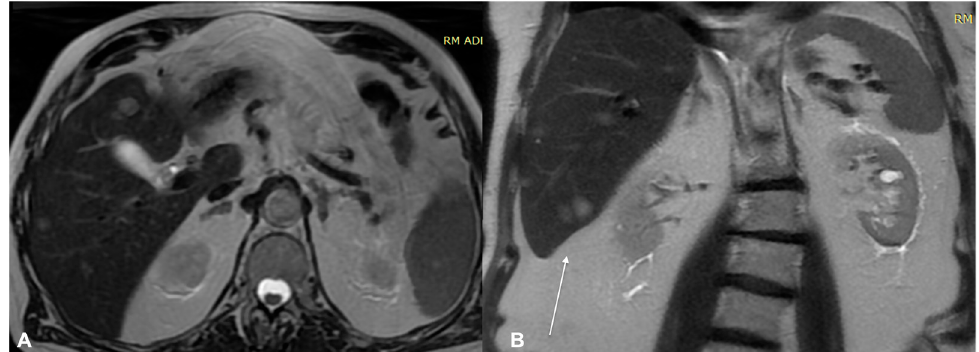
Figure 10. MRI examination of the previous patient performed in August 2021—T2 weighted imaging. Axial section ( A ), Coronal section ( B ). Hypointense areas in the fifth hepatic segment.